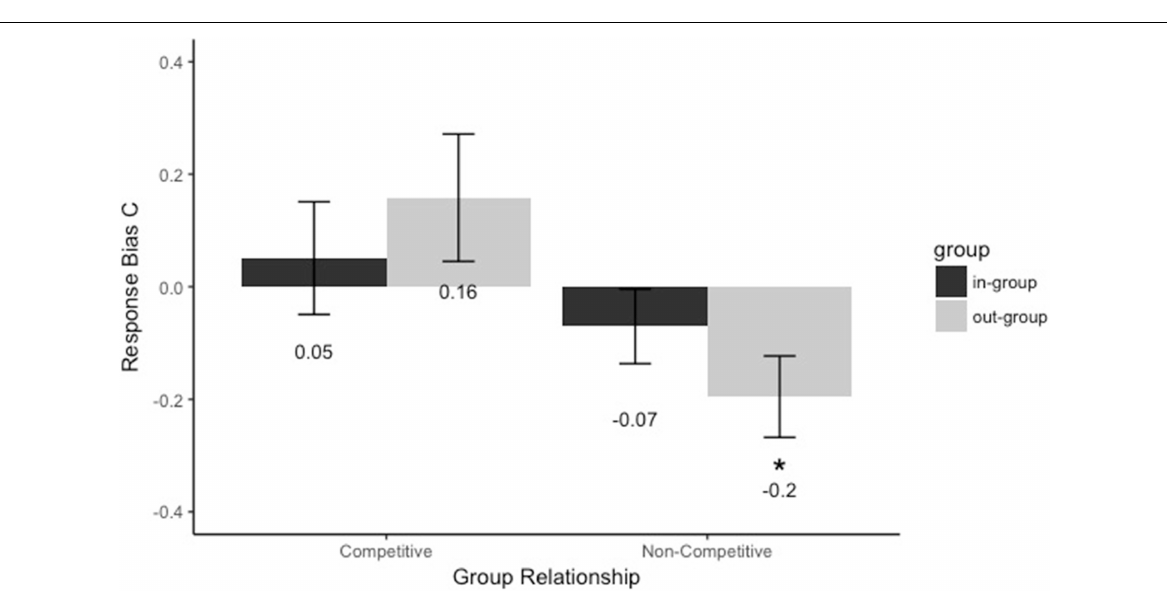
FIGURE 3 | Response bias C for faces assigned to the different groups with and without competitive cues. Black bars refer to in-group members, and gray bars refer to out-group members. Error bars represent standard errors (* p <